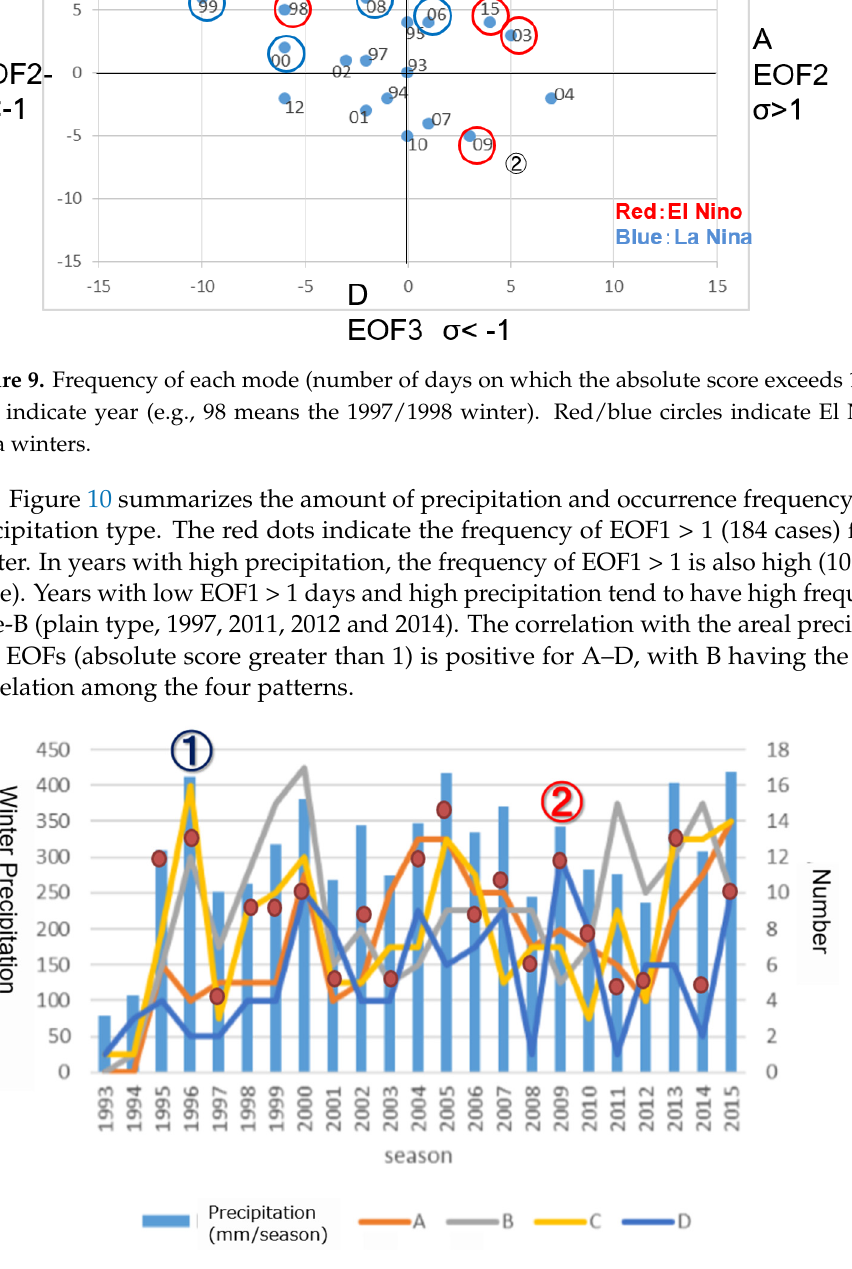
Figure 10. Interannual variation of winter precipitation in target region and the number (day) of appearance of each pattern (where the absolute score exceeds 1). Red dots indicate the number (day) of appearance of EOF1 where the score exceeds 1. ① and ② indicate the year (winter) whose composite sea level pressure (SLP) patterns are shown in Figure 11.